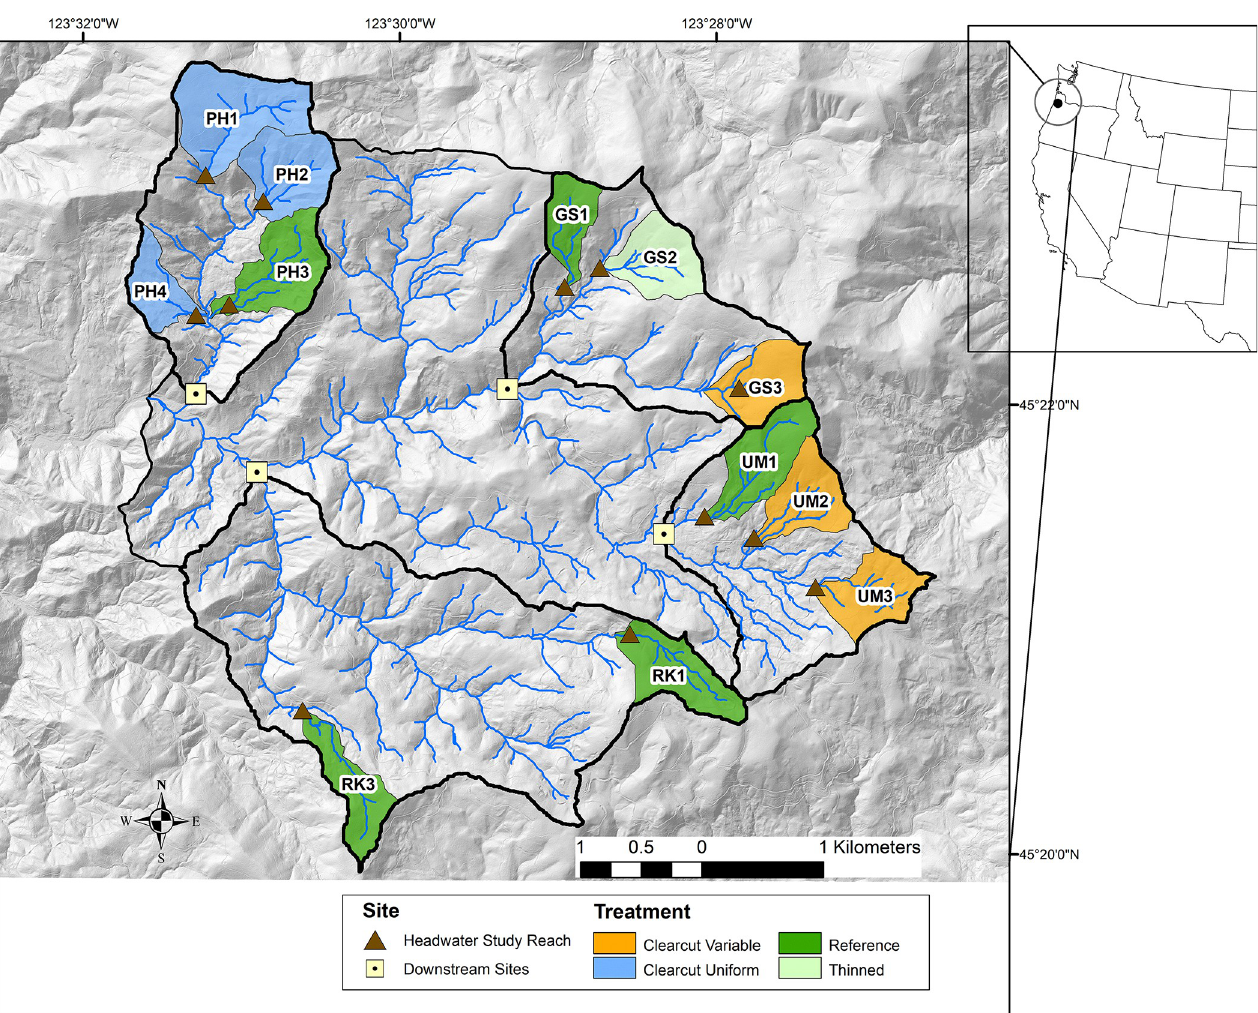
Fig 1. Map of study watersheds in Trask River Watershed Study, western Oregon. Locations of headwater sampling reaches are shown as triangles and downstream sites are noted as squares. Map was created using ArcGIS Pro with LiDAR terrain (https://www.oregongeology.org/lidar/) and derived hydrography. Reference watersheds are shown in dark green, clearcut with variable buffers are shown as orange and clearcut with uniform buffers are show as blue. Light green watershed was thinned with wide unharvested buffers. Created using ArcGIS Pro with LiDAR terrain (https://www.oregongeology.org/lidar/) and LiDAR-derived